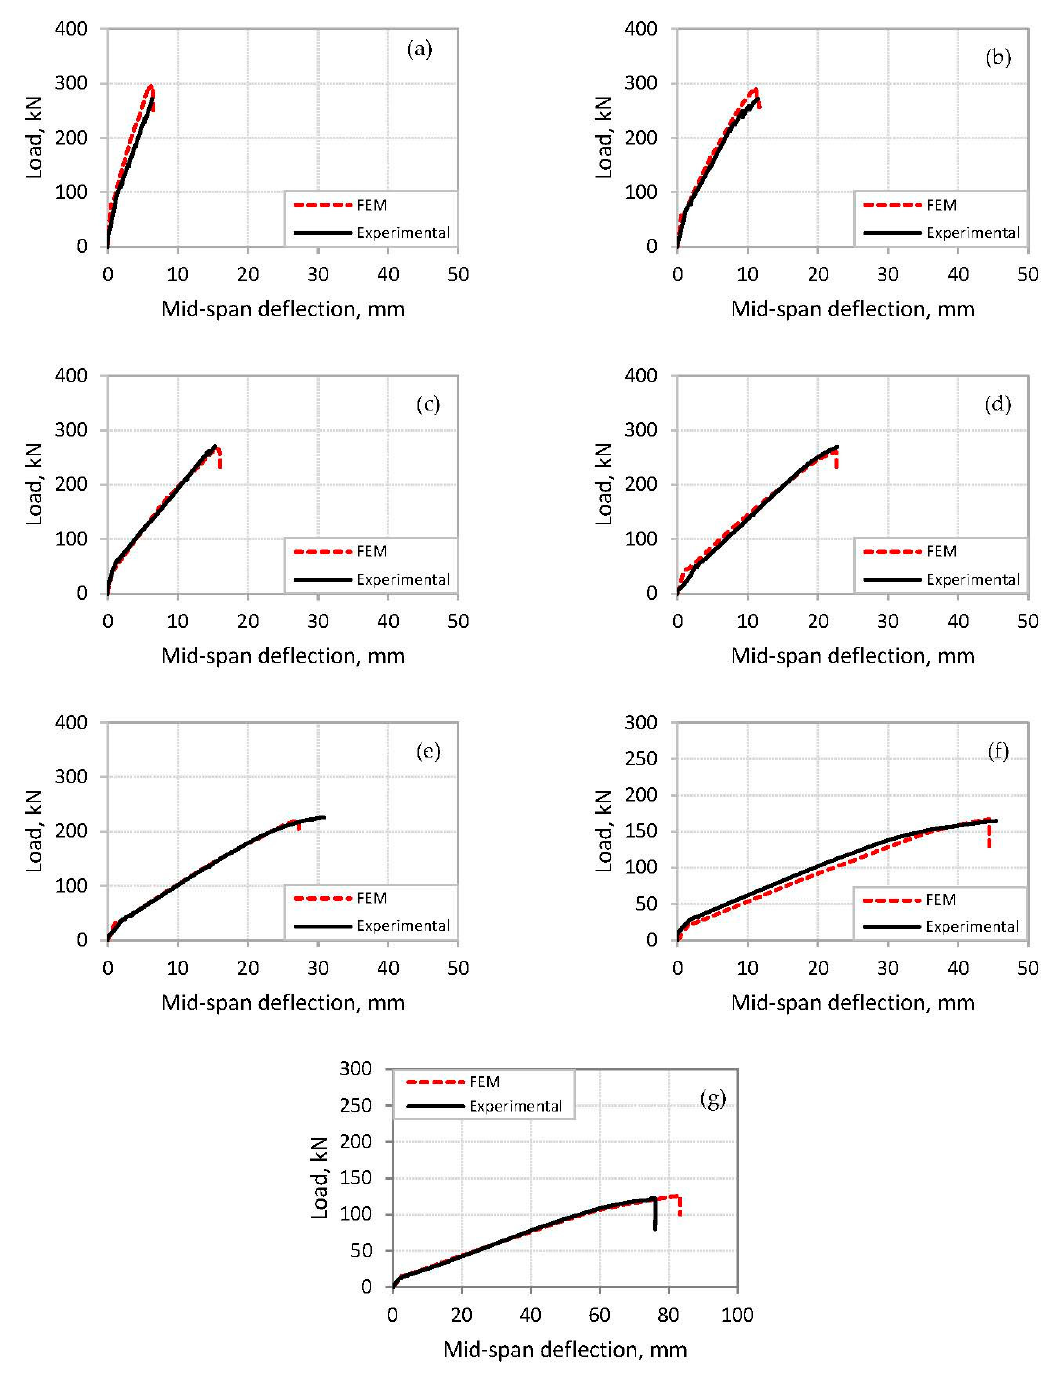
Figure 11. Load-deflection curves of analyzed beams obtained from experiments [6] and FE model: ( a ) beam S-1.5; ( b ) beam S-2.0; ( c ) beam S-2.5; ( d ) beam S-3.0; ( e ) beam S-3.5; ( f ) beam S-5.0; ( g ) beam S-7.0.